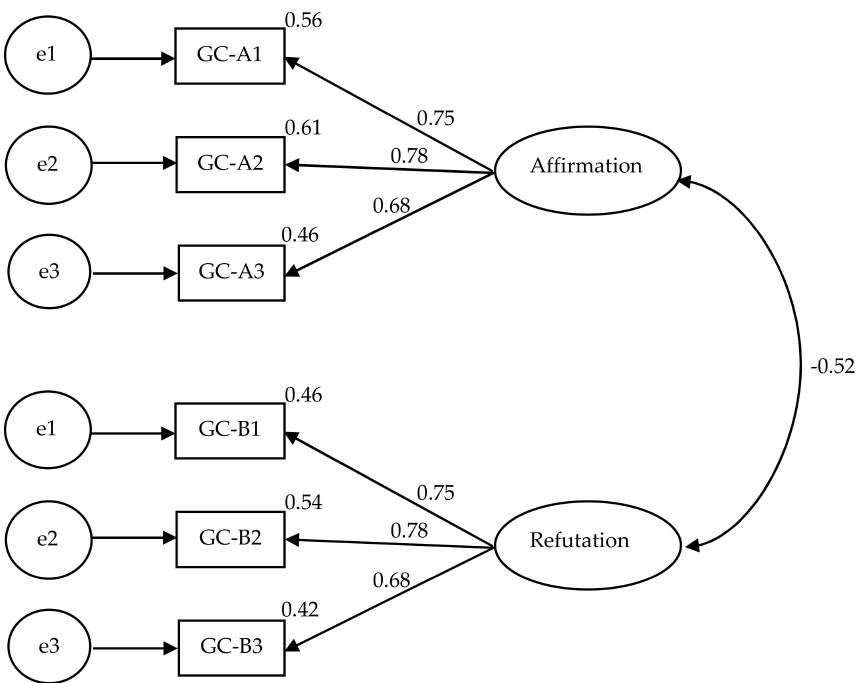
Figure 1. Results of confirmatory factor analysis showing items’ loadings for a two‑factor model for Goal Ambivalence Scale based on data from Study 1.